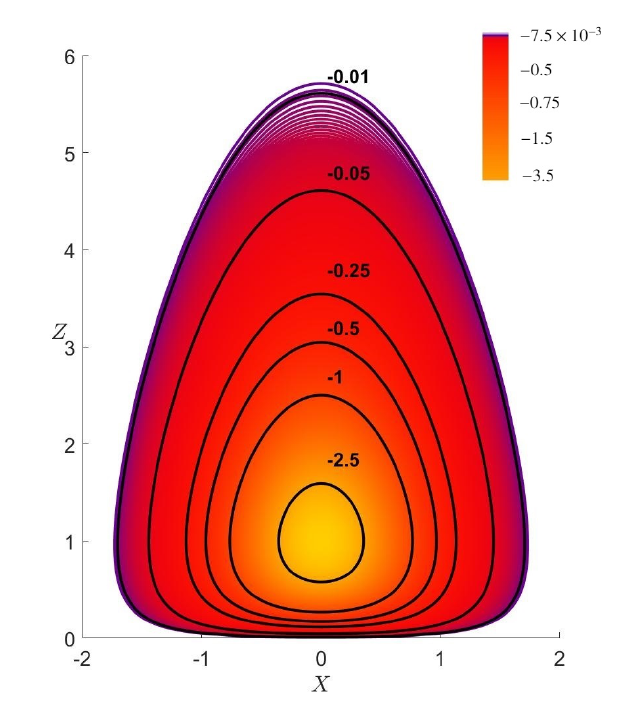
Figure 3. The radius–height plot of dimensionless isobars for v φ 0 / v 0 = 9.34. Axis labels given by Z = z and X = x , where x ∈ [ − r , r ] r 0 L